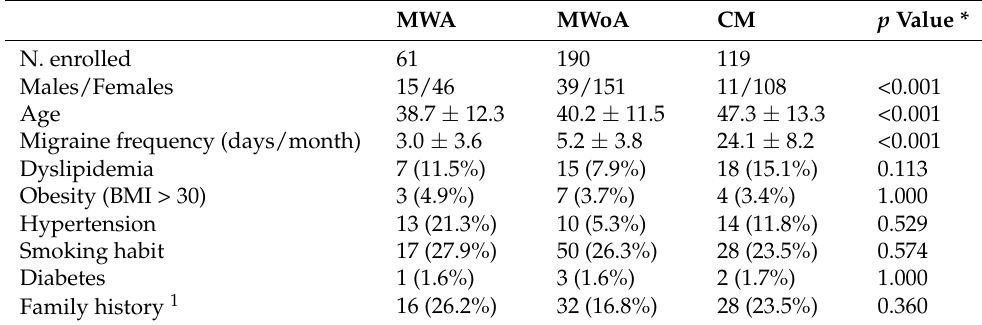
Table 1. Patients’ clinical and demographic characteristics.